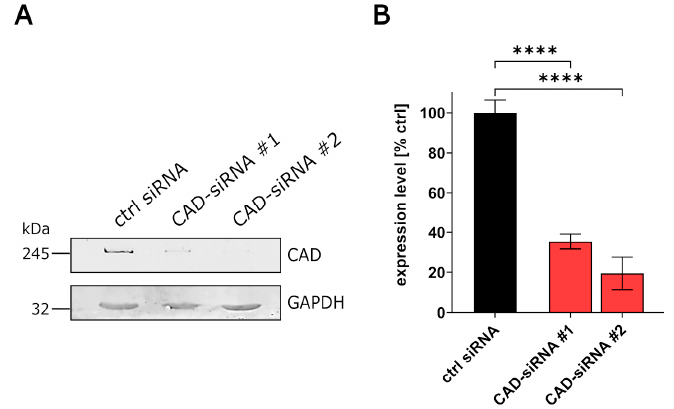
Figure 1. Quantification of CAD knockdown. ( A ) Analysis of CAD knockdown. 293T cells were transfected with siRNAs targeting CAD (CAD-siRNA), or a negative control (ctrl siRNA). The cells were harvested 48 h post-transfection and the lysates were subjected to SDS-PAGE and Western blotting. ( B ) Quantification of CAD knockdown. The Western blot signals for CAD knockdown (as shown in Figure 1A) were measured and normalized to the GAPDH signals. The negative control (ctrl siRNA) was set to 100% and the e ffi ciency of CAD knockdown was calculated (**** p ≤